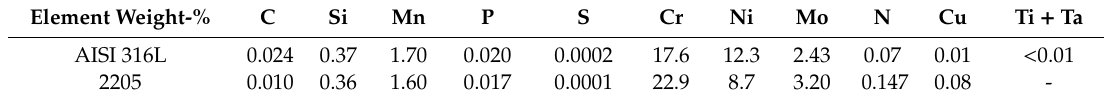
Table 1. Chemical composition of the base (AISI 316L) and filler (2205 duplex) material. Element Weight-%